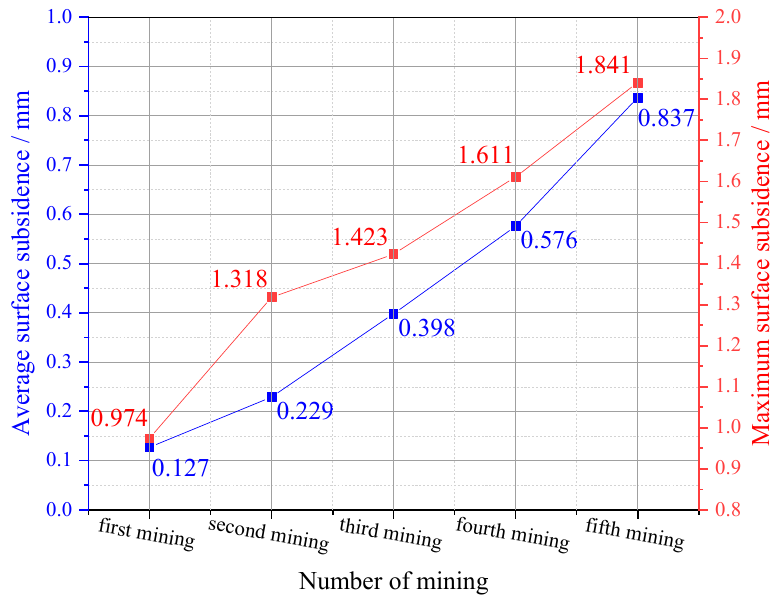
Figure 8. Statistical curve of surface settlement.